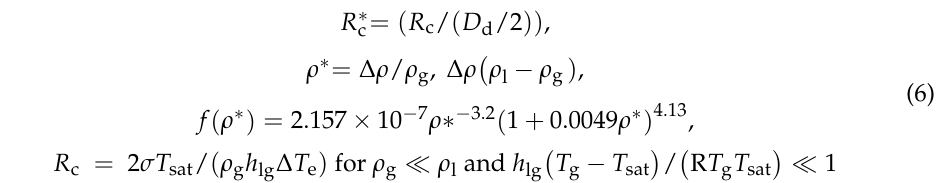
Table 5. Typical kernels of bubbles coalescence rate.